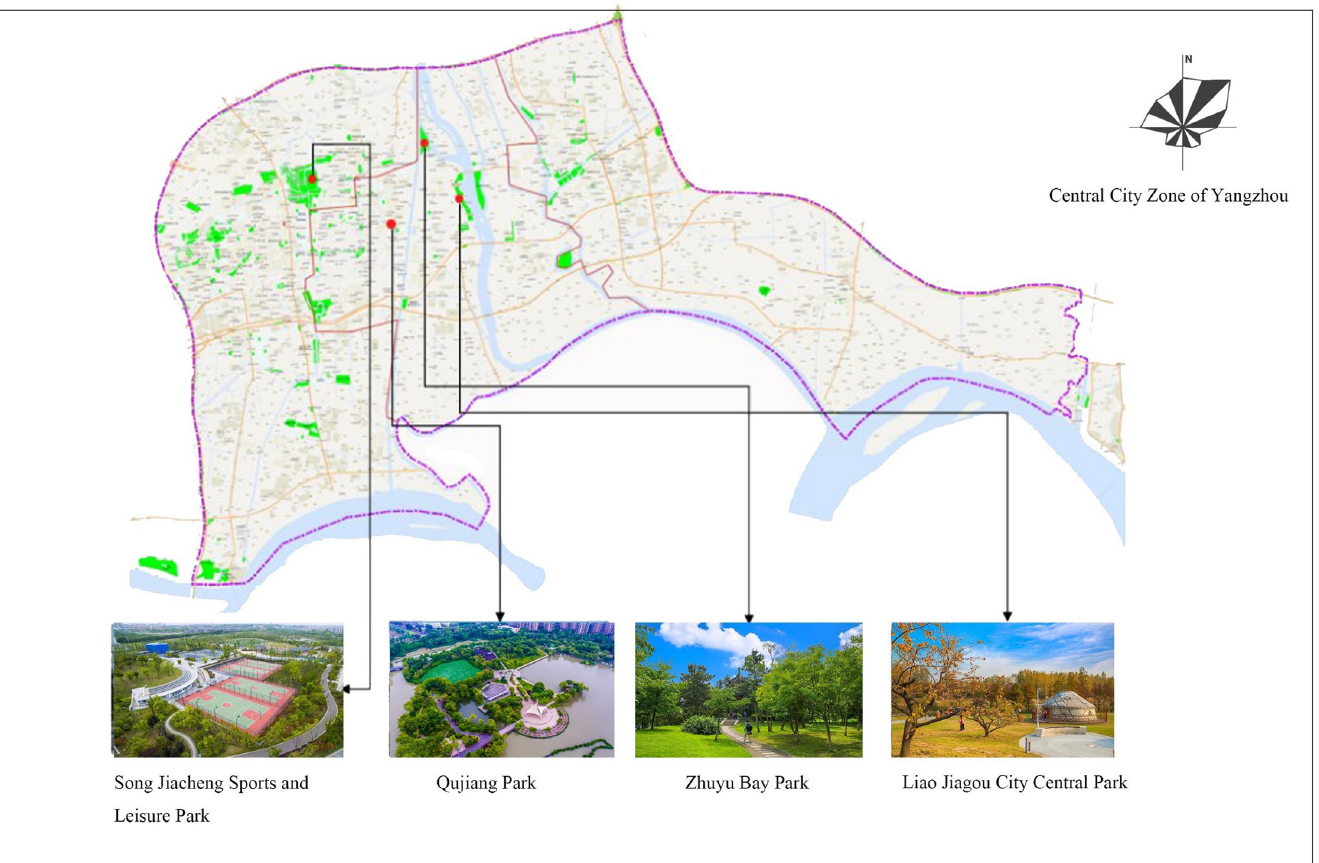
Fig 1. The Location of four typical urban parks in Yangzhou, China. (Reprinted from map data © Open Street Map contributors, map layer by Esri, under a CC BY 4.0 license).